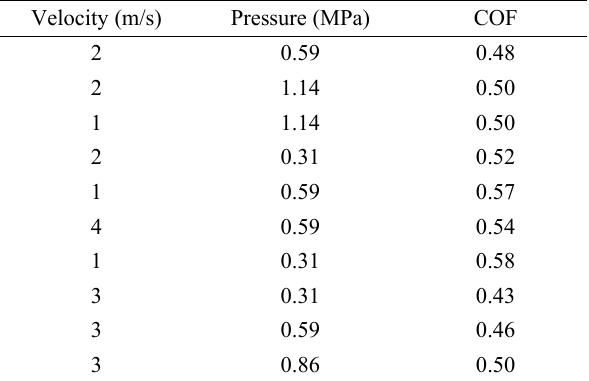
Table 1 Sliding velocities and contact pressures tested with